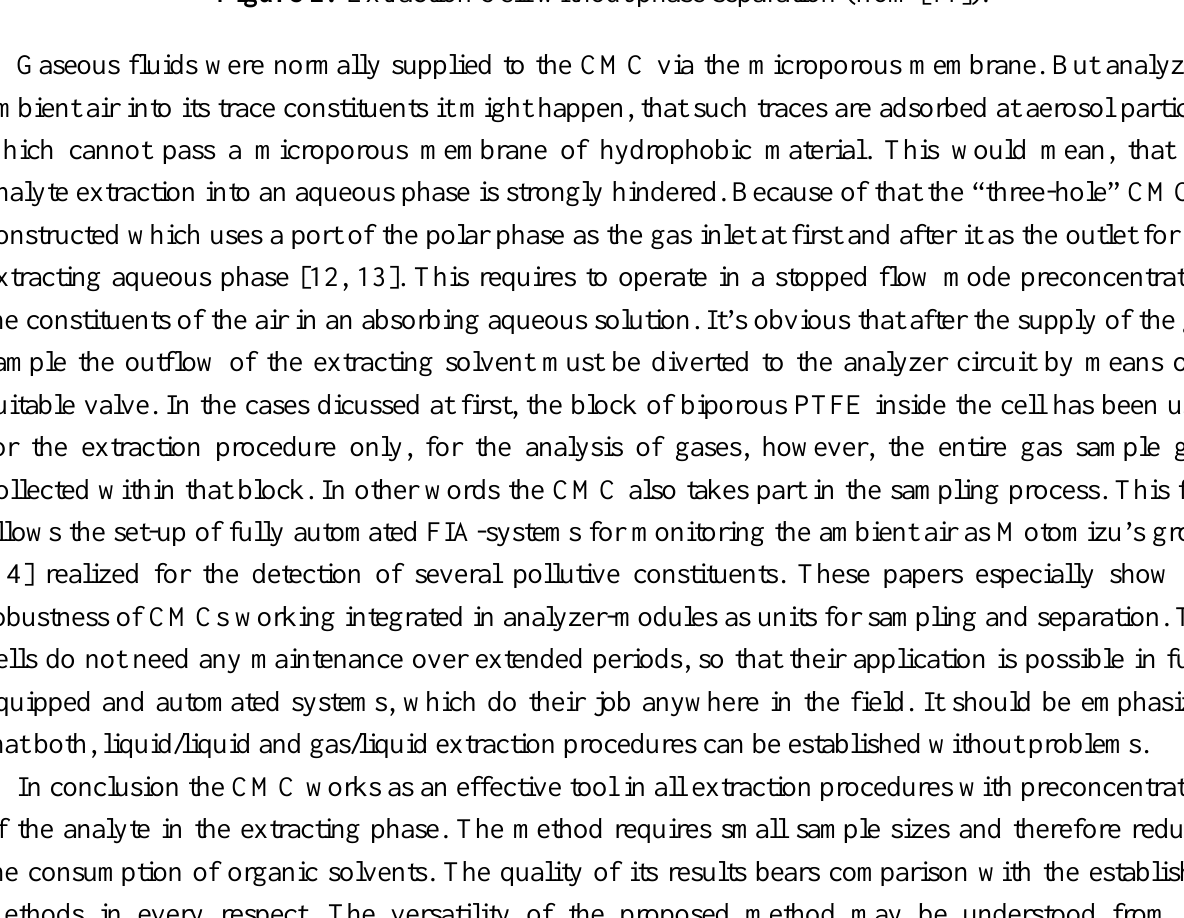
Figure 2. Extraction Cell without phase separation (from